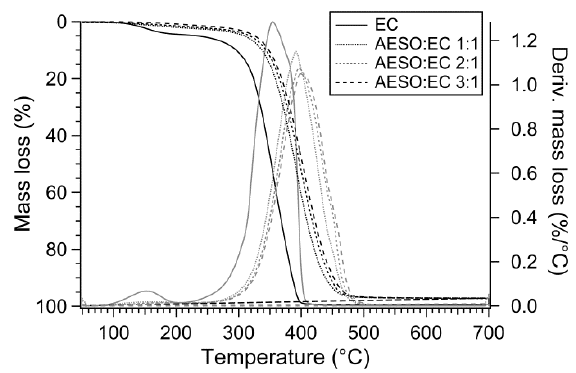
Figure 5. Thermogravimetric curves for poly(EC) and AESO-EC